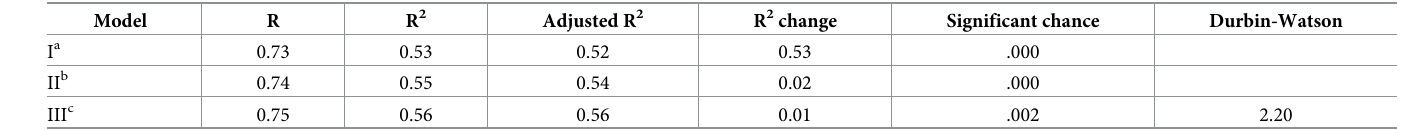
Table 5. Model summary: Effect of visibility, snow quality and wind on the EE � .